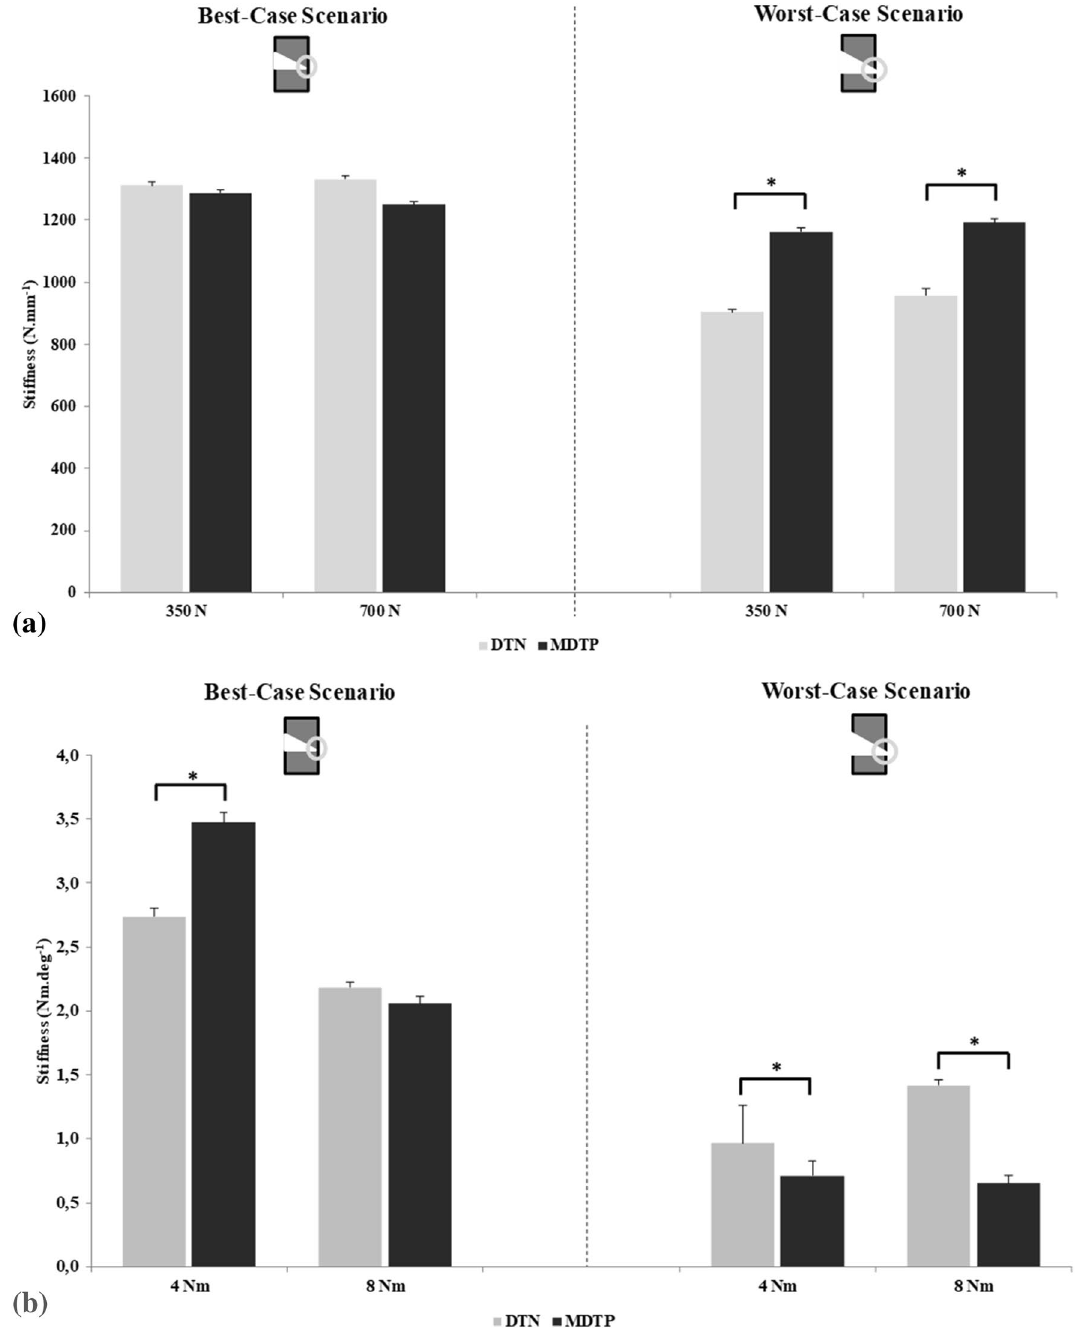
Figure 3. Mean ± 2SD compression stiffness ( a ) and torsional stiffness ( b ) results for the two surgical scenario (n = 8 samples for each implant group) and two loading levels. Bars marked with *indicate a significant difference between the implant